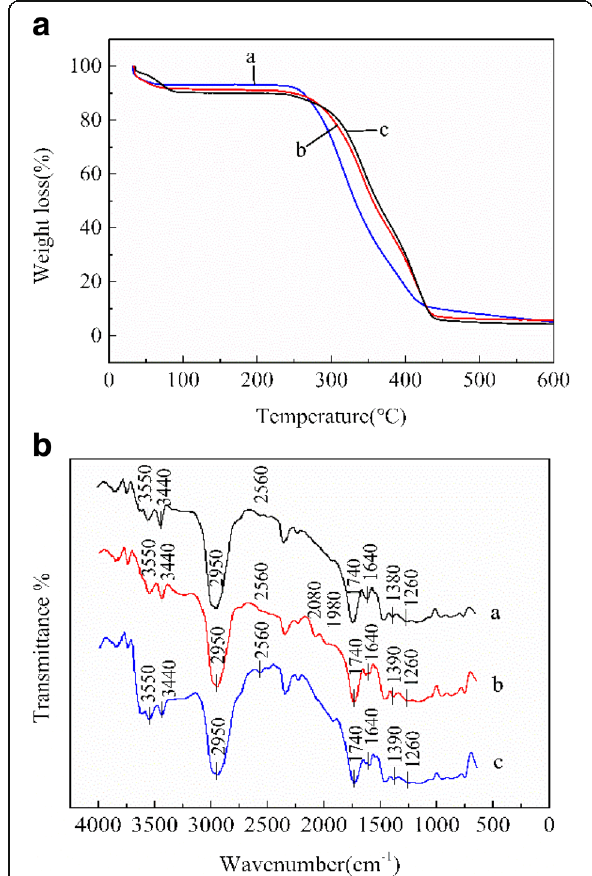
Fig. 4 a TGA curves of a: unleached Pd(II) IIPs, b: leached Pd(II) IIPs, c: NIPs; ( b ) FTIR spectra of a: unleached Pd(II) IIPs, b: leached Pd(II) IIPs, c: NIPs